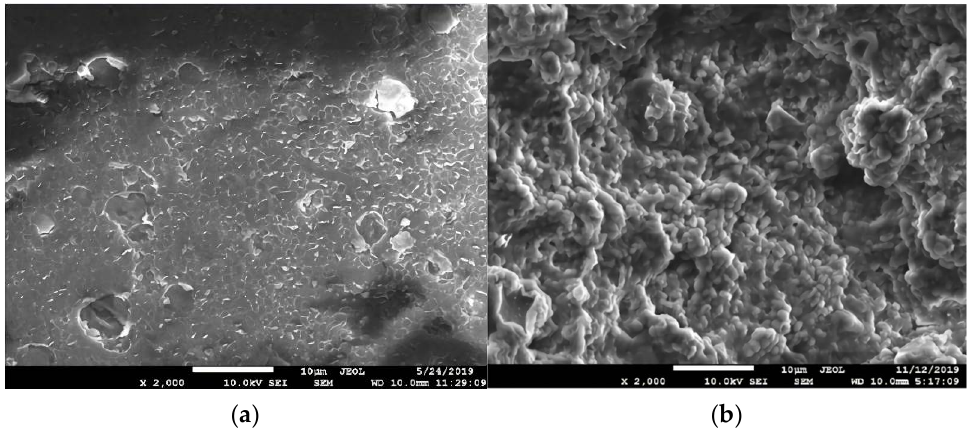
Figure 2. SEM of packing before and after membrane hanging in the biofilter. Original packing ( a ); Packing after hanging film ( b ).